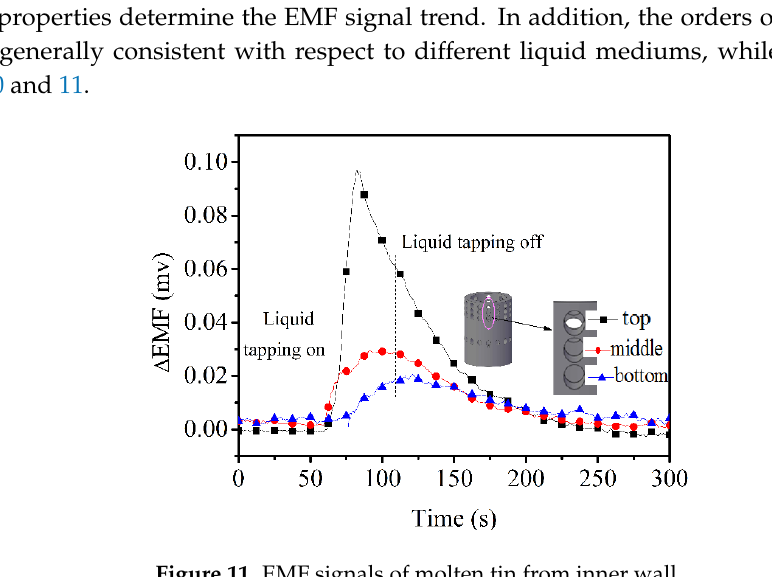
Table 4. Summary of EMF signals from water and oil at different locations on inner wall and outer wall.